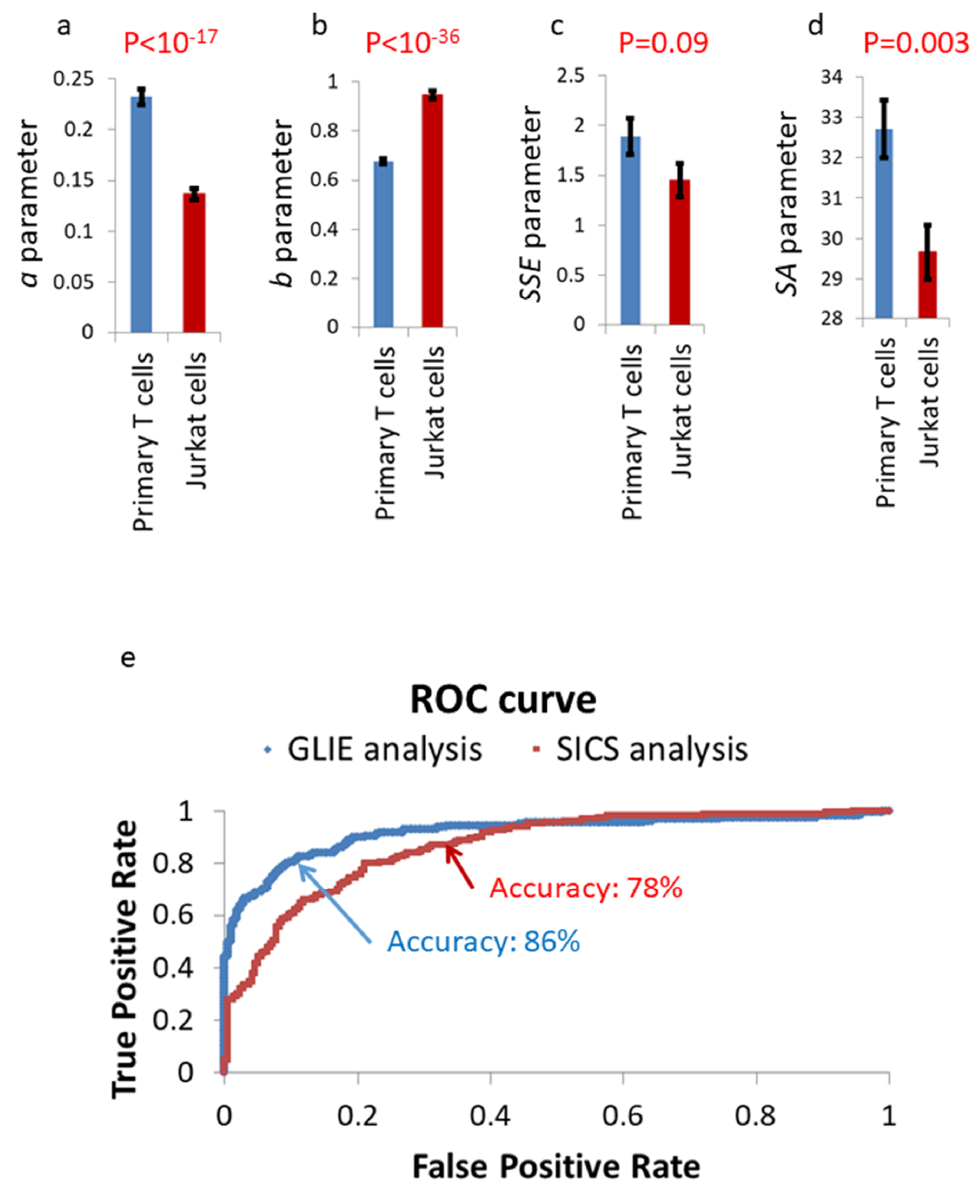
Figure 13. SICS fluctuation parameters in primary T cells (n = 219) in comparison to Jurkat cells (n = 161). Parameter a values ( a ) or parameter b values ( b ) or parameter SSE values ( c ) or parameter SA values ( d ) in primary T cells vs. Jurkat cells. ( e ) Receiver-Operating-Characteristic (ROC) curves for the differentiation of Jurkat cells from primary T cells utilizing binary logistic regression. These curves are based on the results of SICS or GLIE fluctuation parameters in panels a – d and Figure 12 panels a – e . Error bars in panels a – d are SEM, and p -values are presented in the corresponding panels.